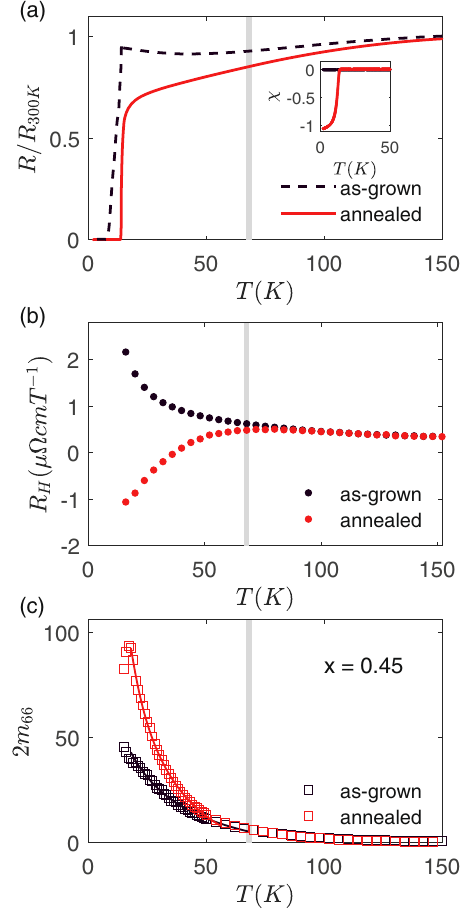
Fig. 4 The effect of annealing on the nematic susceptibility of Fe 1 + y Te 1 − x Se x . a – c Temperature dependence of ( a ) normalized in-plane resistivity ( R / R 300K ), b Hall coef fi cient R H and c elastoresistivity coef fi cient 2 m 66 of as-grown (black) and annealed (red) samples for x = 0.45. The vertical gray line marks the temperature below which the behavior of annealed and as-grown samples starts to deviate from each other. Inset of a shows the temperature dependence of the zero fi eld cooling (ZFC) magnetic susceptibility measured at 100Oe (H ∥ ab). The superconducting volume fraction is signi fi cantly enhanced for the annealed